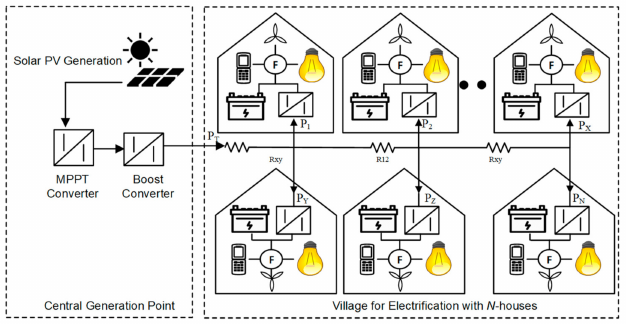
Figure 2. System diagram for centralized generation and distributed storage architecture (CGDSA).